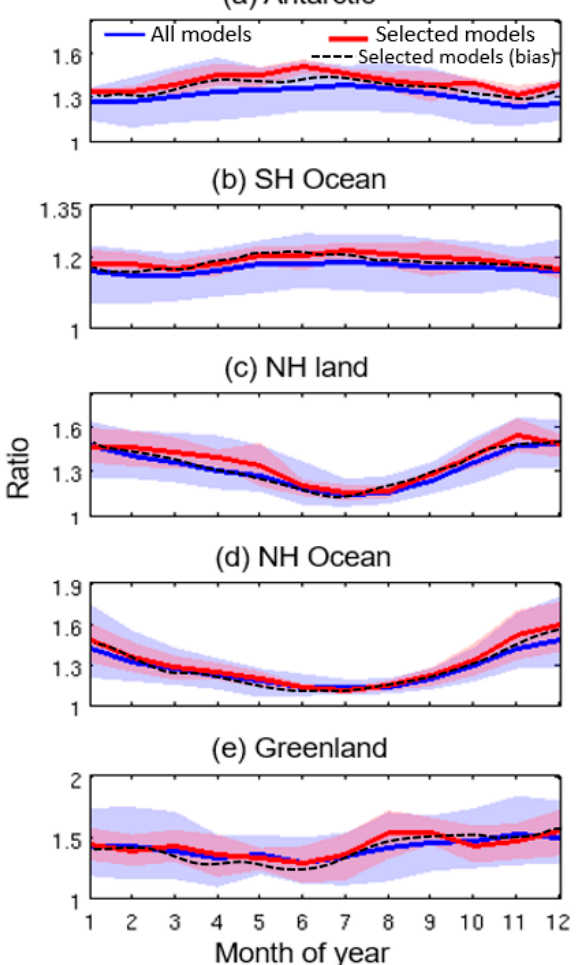
Figure 5. The ratio of future mean precipitation (2071–2100) over the present climate is plotted separately for each month and each region. The median and 20–80% ensemble range of models are shown using line and shaded areas in blue (for all models) and red (for the subset of selected models) in each region.